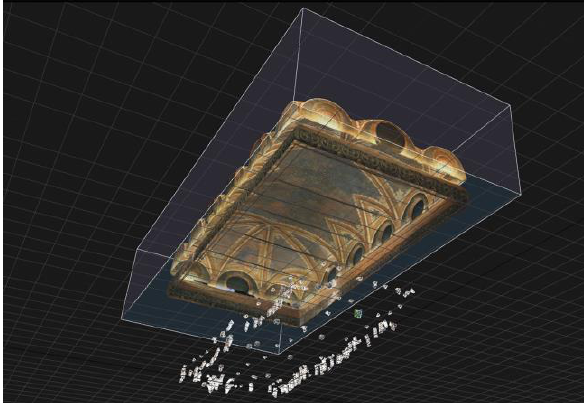
Figure 6. Textured mesh of the vault reconstructed using both laser scanner and photogrammetric data within RealityCapture.